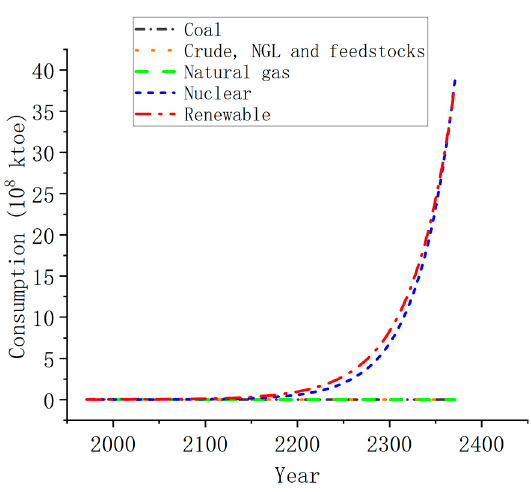
Figure 6. The energy supply in the influenced model. Note: coal is minimal for 1971–2050 and largely coincides with the natural gas line.